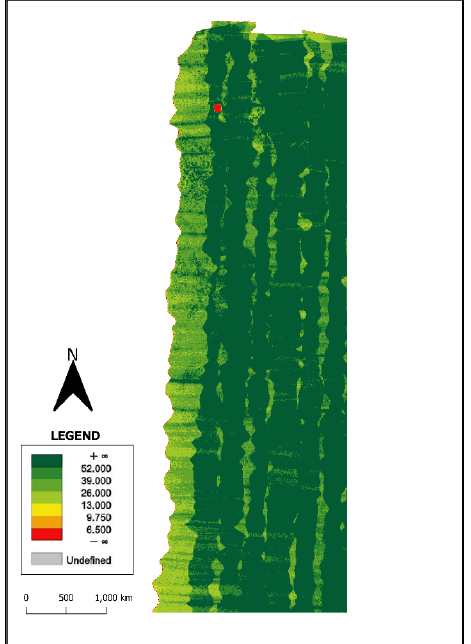
Figure 3. Average Lidar point density computed using 2×2 m